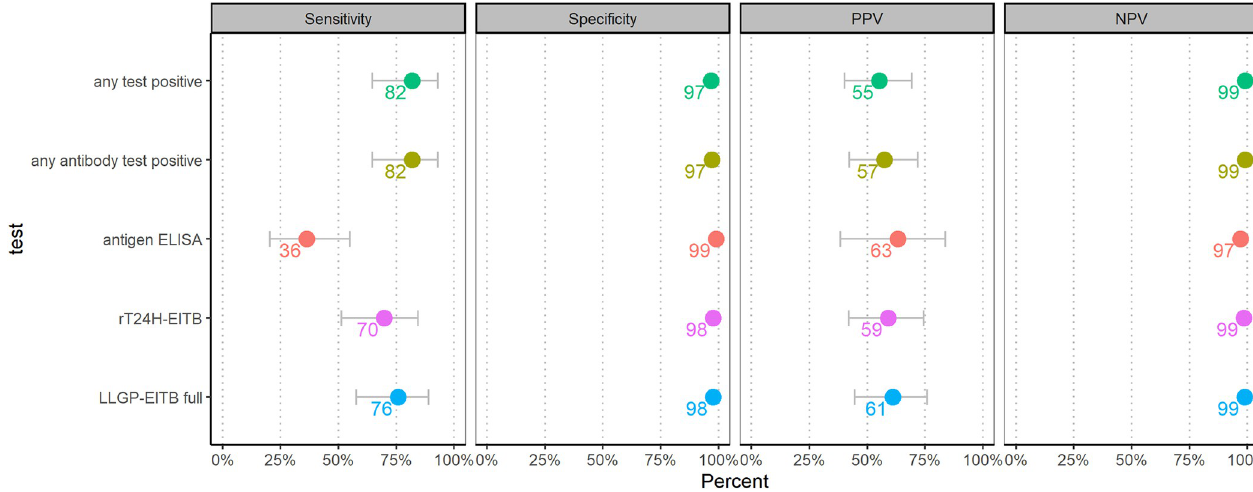
Fig 3. Test performance and findings on computed tomography.